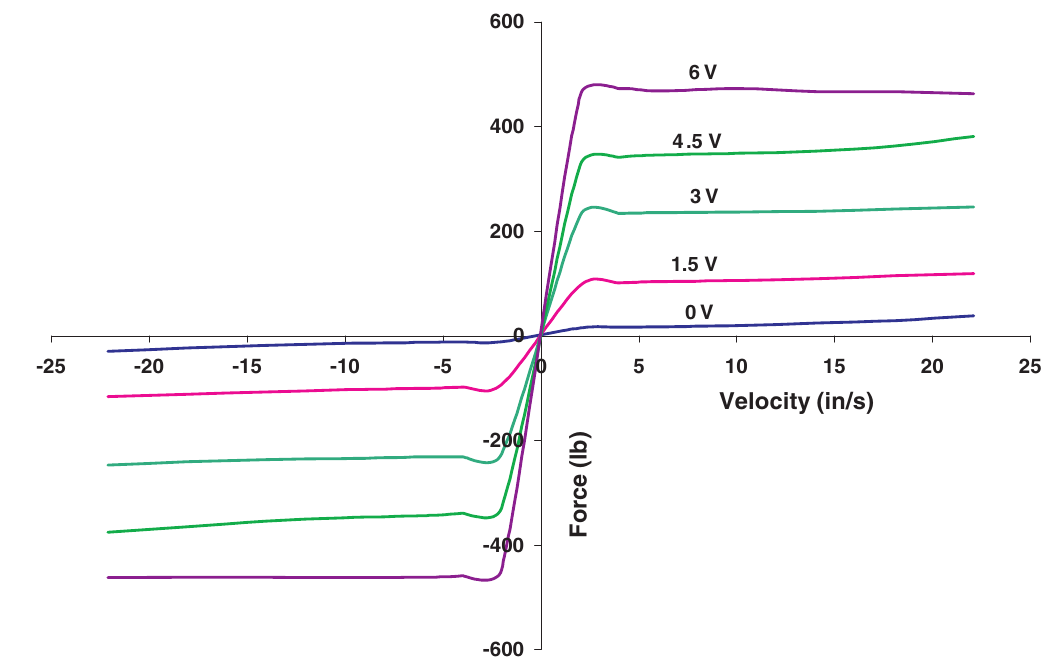
Fig. 4. Damping curves for the gun recoil MR damper at different